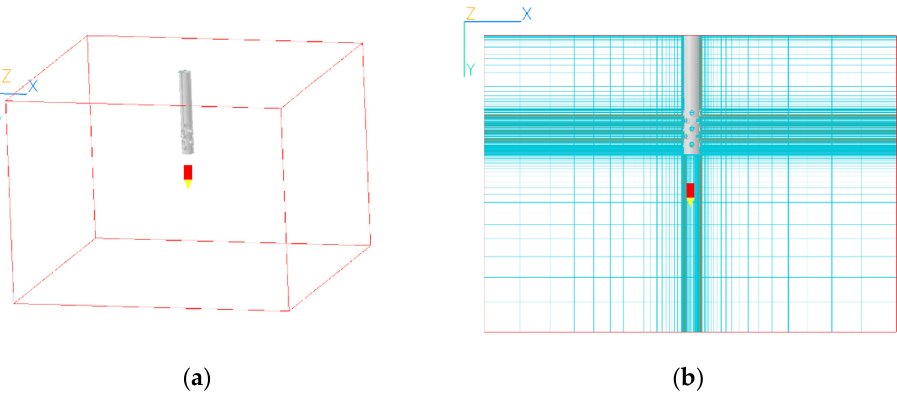
Figure 4. Numerical domain and the optimized numerical grid: ( a ) domain size: 0.415 m × 0.3 m × 0.415 m, and ( b ) typical numerical grid (84 × 145 × 84).